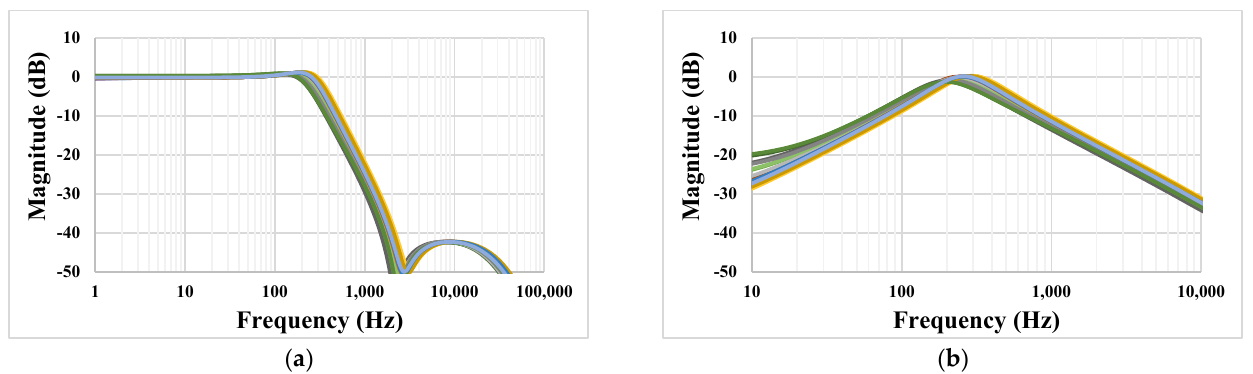
Figure 10. The simulated frequency characteristic of the LP ( a ) and BP ( b ) filters with PVT corners. The histograms of the −3 dB cut-off frequency and low frequency gain of the LP filter with Monte Carlo (MC) process and mismatch analysis are shown in Figure 11a and 11b, respectively. For the −3 dB cut-off frequency, the mean value was 323.86 Hz and the stand- ard deviation 17.95 Hz, while the mean value of the gain was 432 mdB with a standard deviation of 150.5 mdB. Note that, thanks to the electronic tuning ability of the DDTA, any possible deviation of the filter parameters could be readjusted by the setting current I set . Figure 11. The histogram of the −3 dB cut-off frequency ( a ) and low frequency gain ( b ) of the LPF with 200 MC runs.